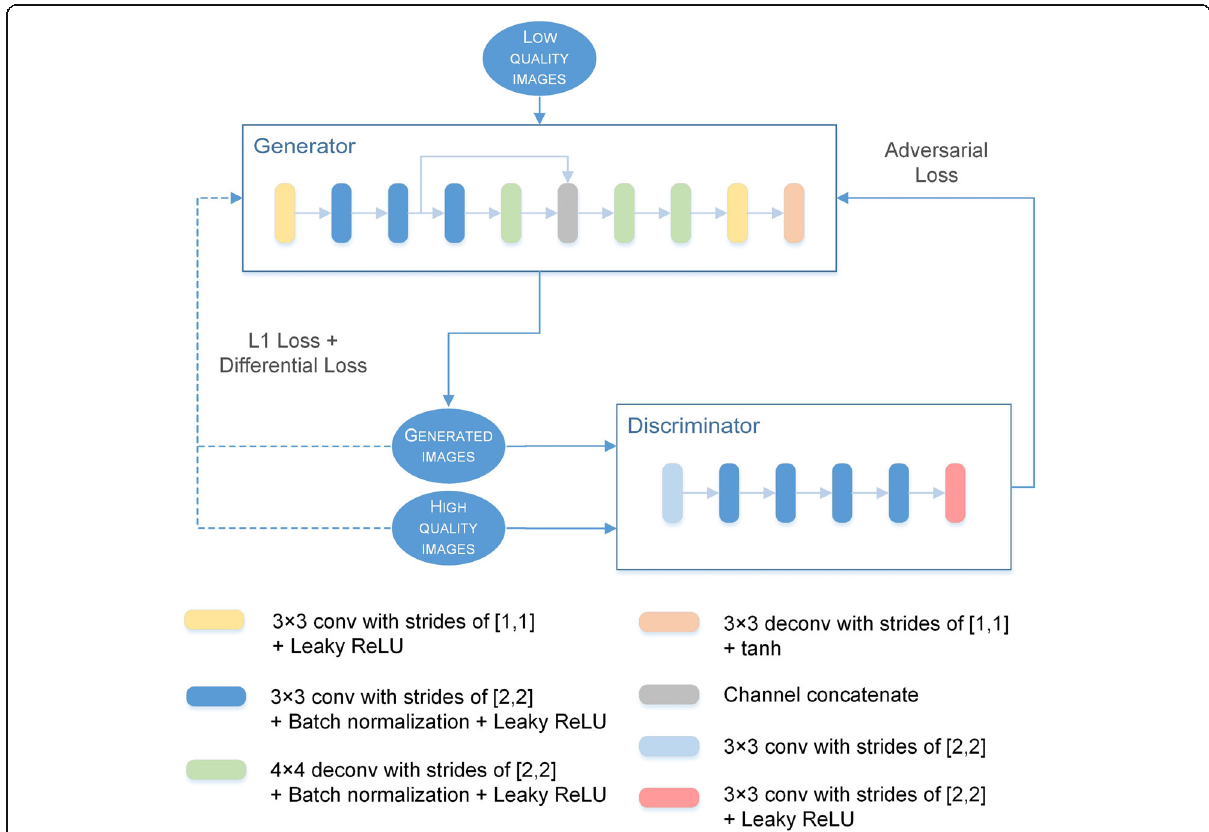
Fig. 1 Flow chart of the reconstruction